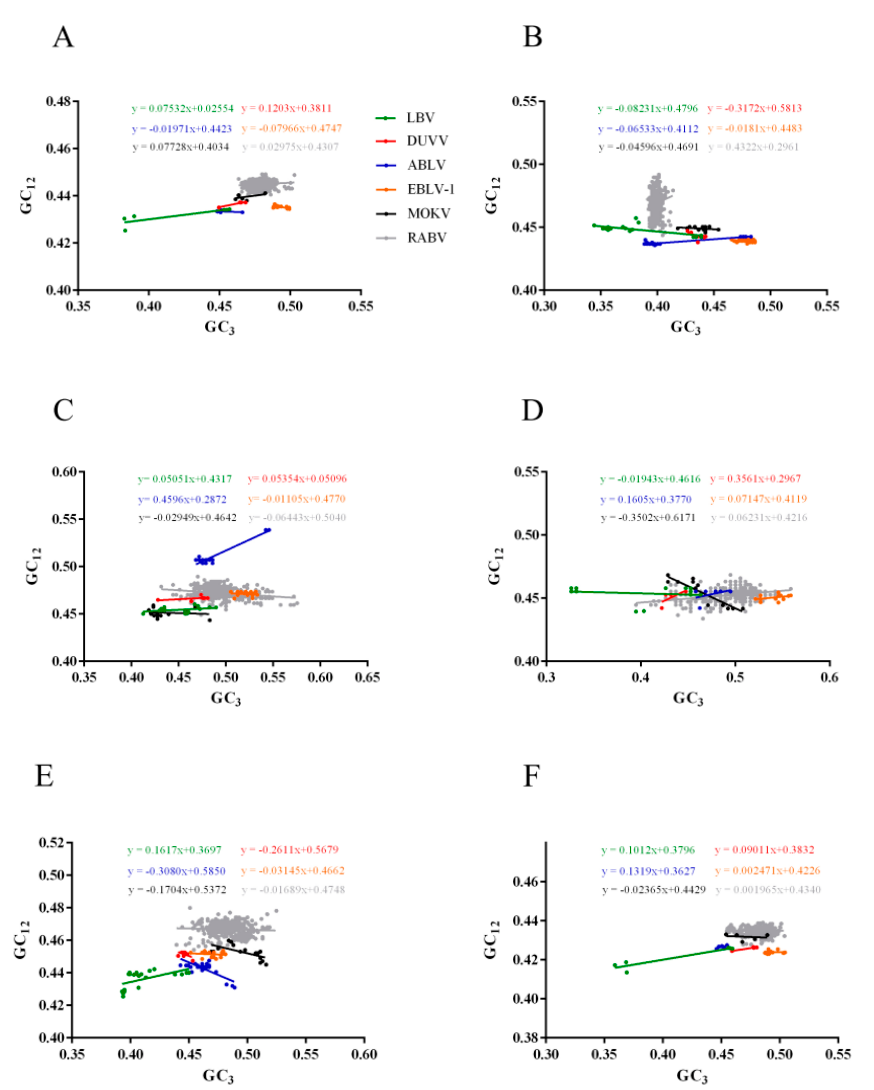
Figure 5. Neutrality plot analysis. ( A ) Whole genome; ( B ) N; ( C ) P; ( D ) M; ( E ) G; ( F ) L. The colour coding is the same as that of ( A ).